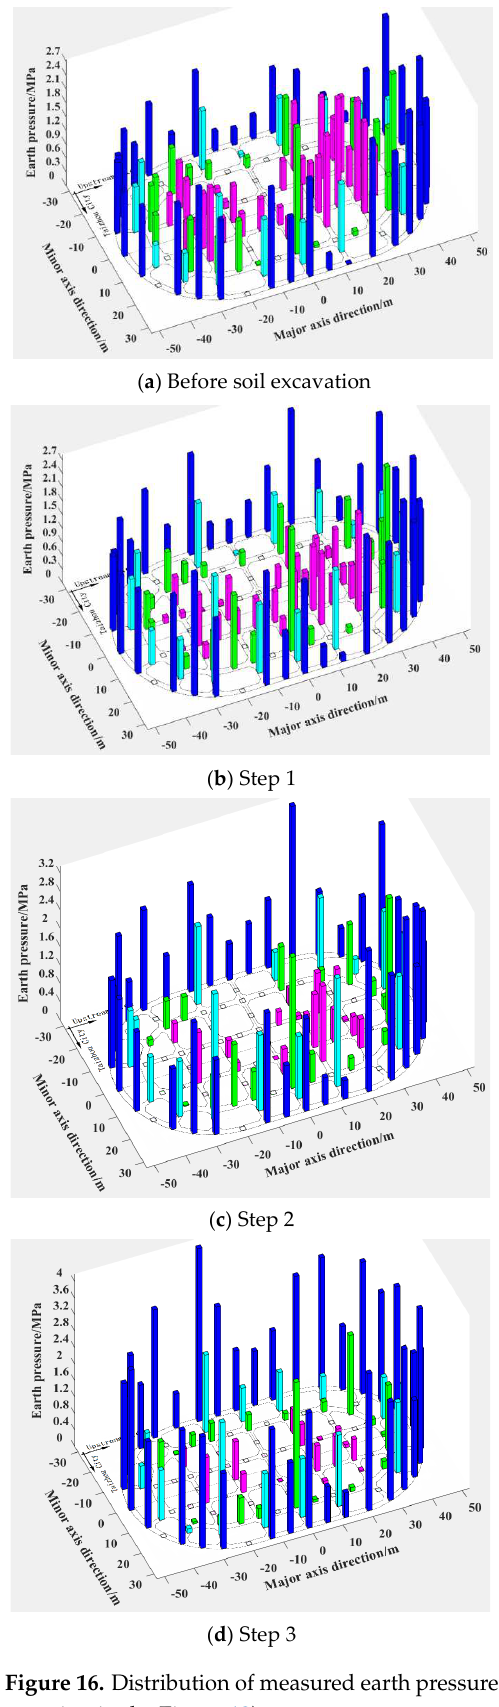
Figure 16. Distribution of measured earth pressure with soil excavation step (the color is for the same meaning in the Figure 12).